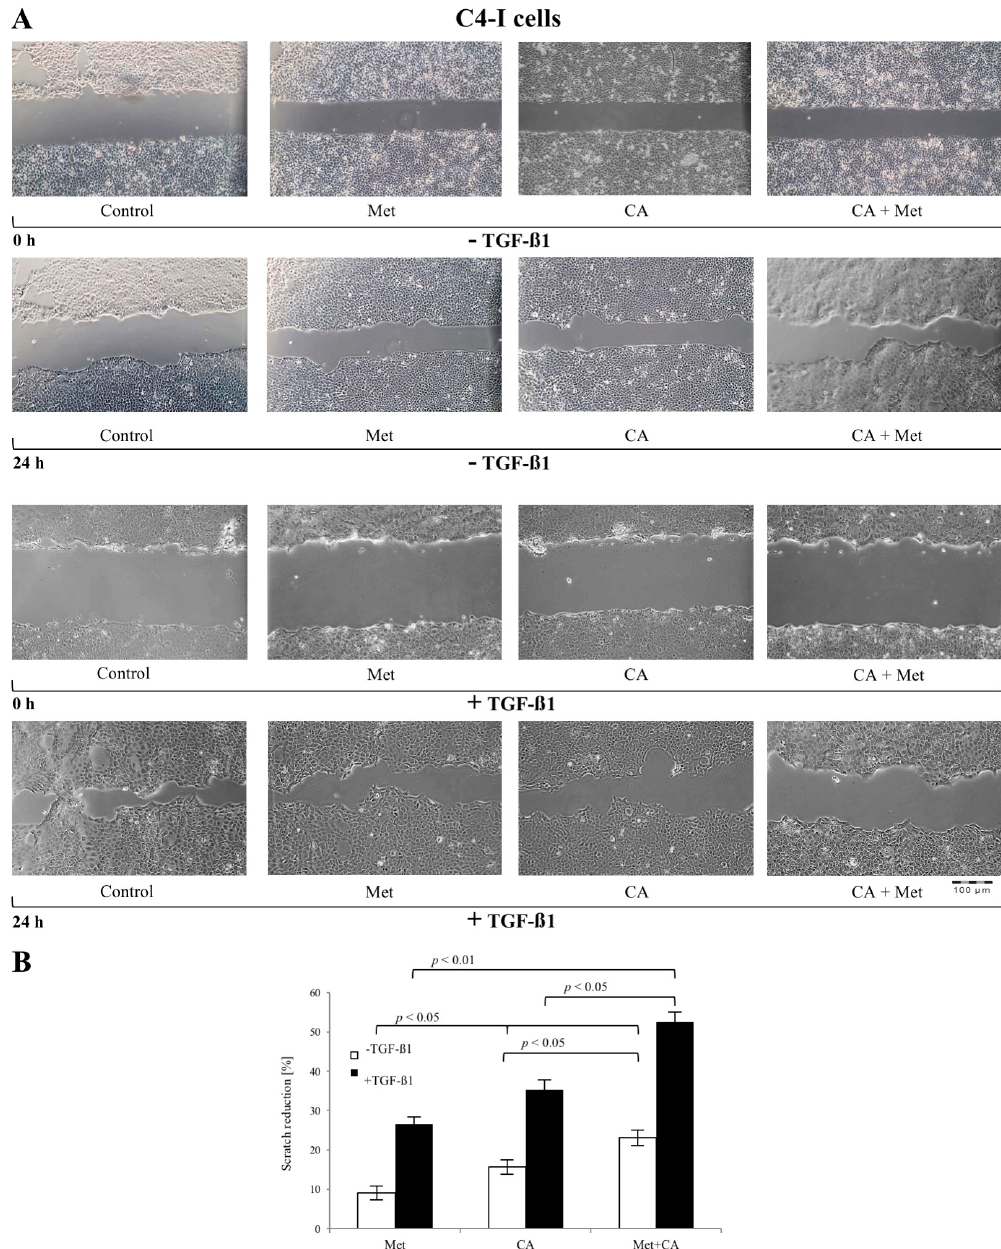
Figure 2. The effect of Caffeic Acid (CA) and Metformin (Met) on migration of C4-I cells in vitro ( A , B ). C4-I cells were cultured to sub-confluency and then a scratch was made on the monolayer of cells. Then the cells were incubated with addition of tested compounds (CA at 100 μ M and/or Met at 10 mM) and with/without 10 ng/mL TGF- β 1 for 24 h. For each scratch the images were obtained by an inverted light microscope (Olympus IX-70, Hamburg, Germany) at 0 h and 24 h. The changes of area of each wound was measured using Image J (v1.44; National Institutes of Health, Bethesda, MD, USA) and the migration rate was quantified as a change of the scratch reduction. Note that CA/Met caused the greatest scratch reduction in TGF- β 1-treated cells (( B ), p < 0.01 for CA/Met vs. control, p < 0.05 for CA/Met vs. Met, p < 0.05 for CA/Met vs. CA) as well as in TGF- β 1-untreated cells (( B ), p < 0.05 for CA/Met vs. control, p < 0.05 for CA/Met vs. Met, p < 0.05 for CA/Met vs. CA). All bars show the mean value of three experiments and error bars represent standard error of the mean ( B ).